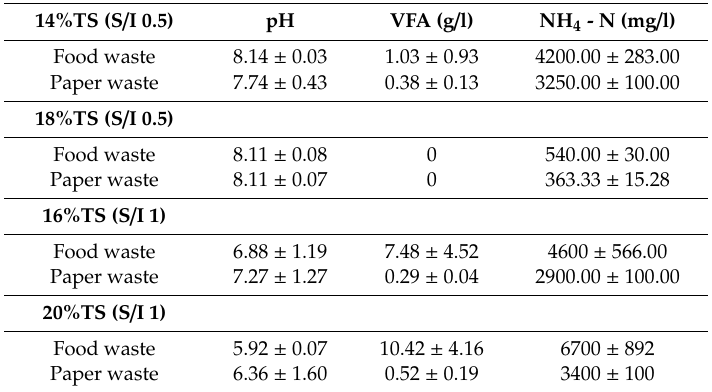
Table 3. Characterization of the digestate residue from dry anaerobic